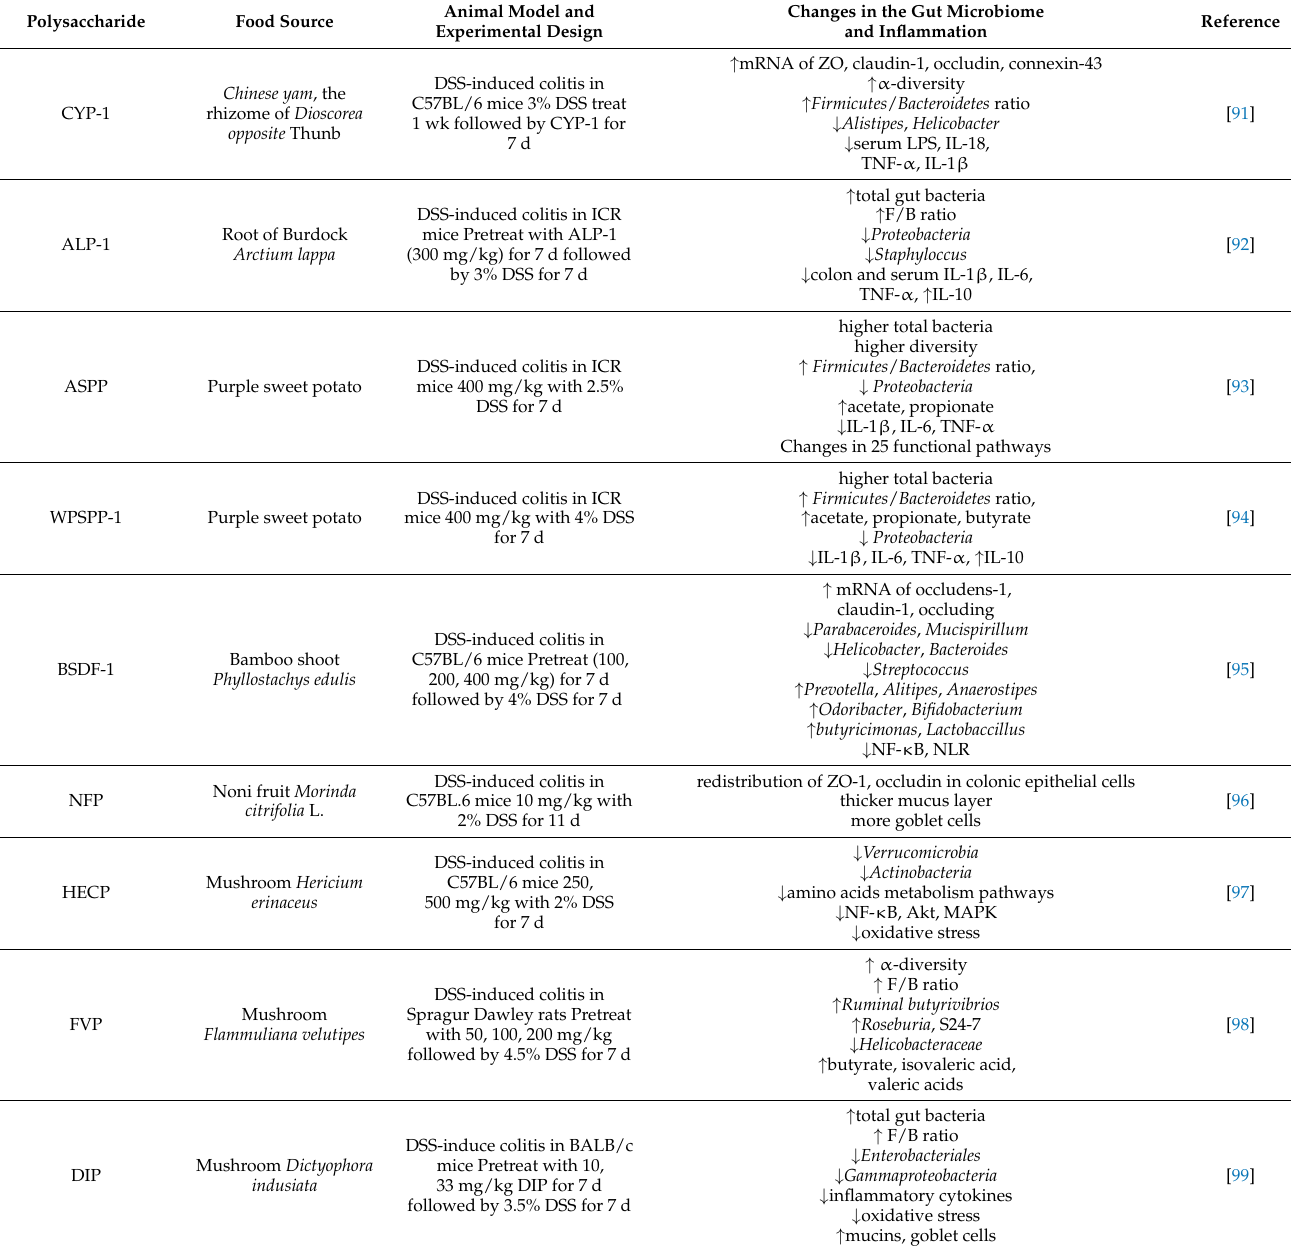
Table 1. Beneficial effects of plant polysaccharides in animal models of